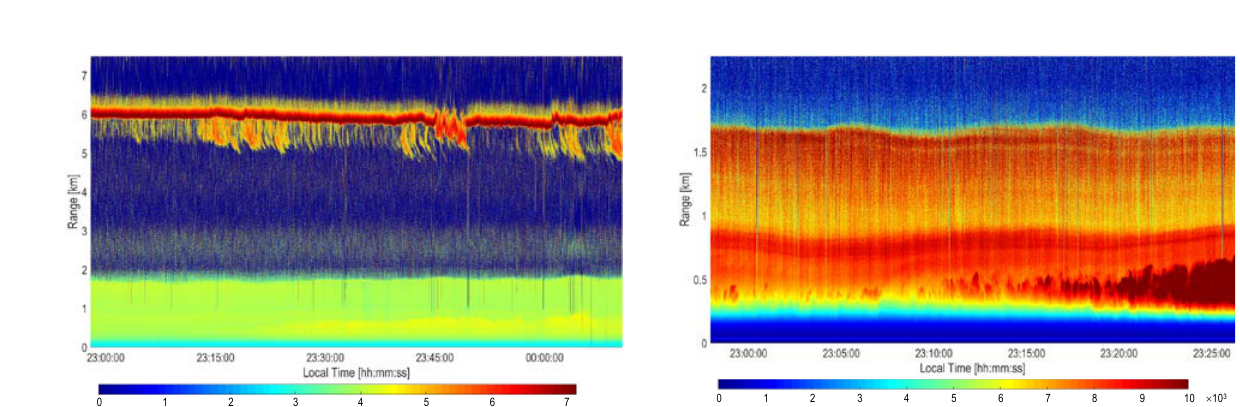
Figure 5. False color diagram for far–field record of cirrus clouds and boundary layer structures. Colors represent the logarithmic scale of the 2- µ m rang corrected signal strength.